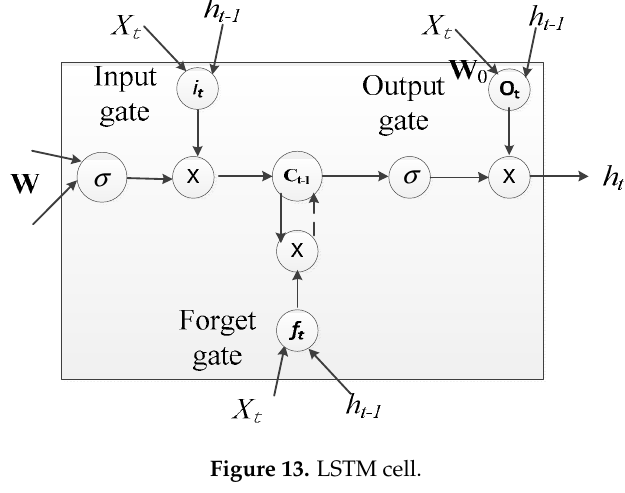
Figure 13. LSTM Figure 13. LSTM cell. Table 2. Performance metrics.